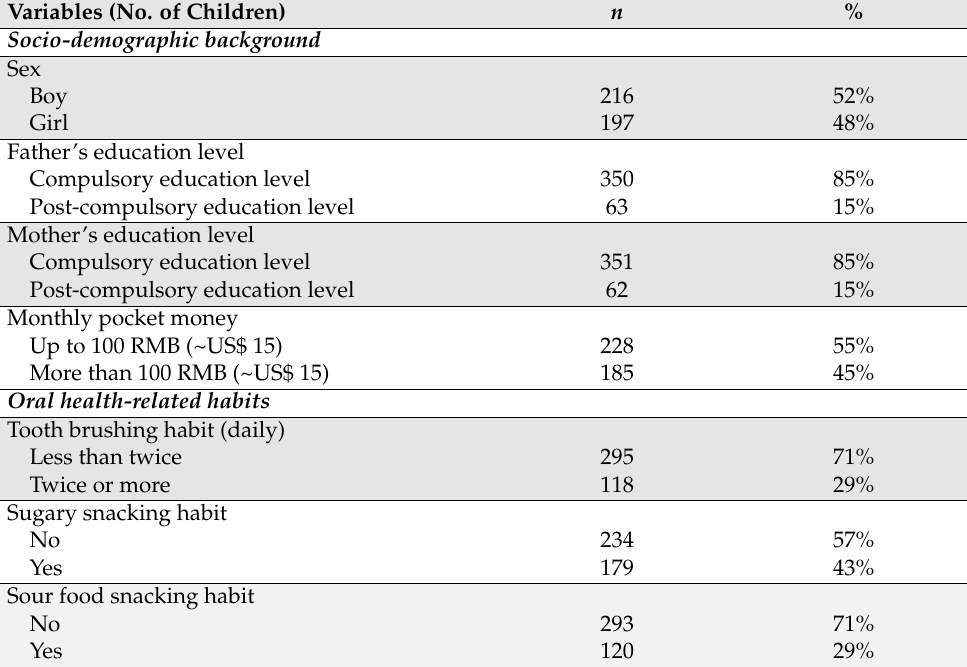
Table 1. Sociodemographic background and oral health-related habits of the 12-year-old Hani children (N =